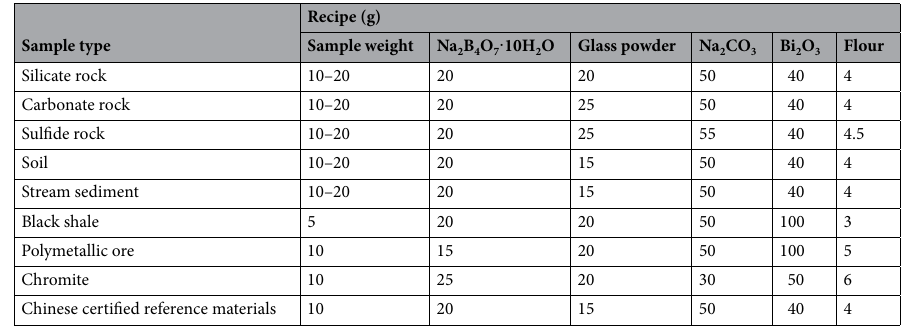
Table 3. Bi fire assay recipes for geochemical